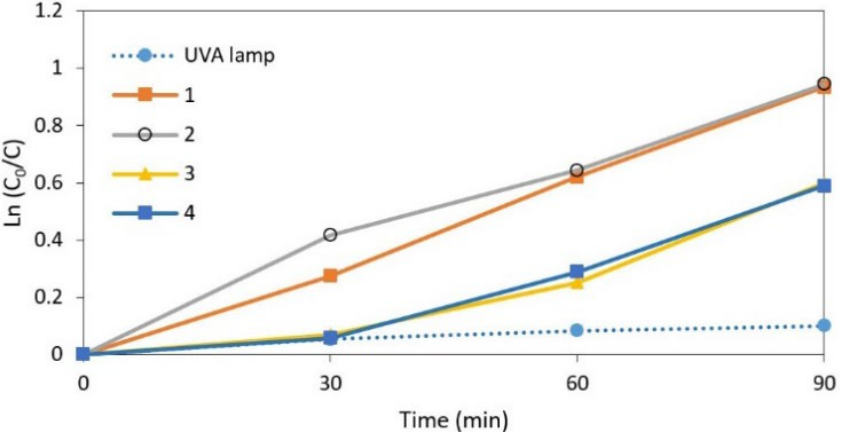
Figure 4. Photocatalytic degradation of MB solution under UVA light for the optimization process samples sprayed according to Table 2. Table 4. Photocatalytic performance of the optimization process samples sprayed according to Table 2.